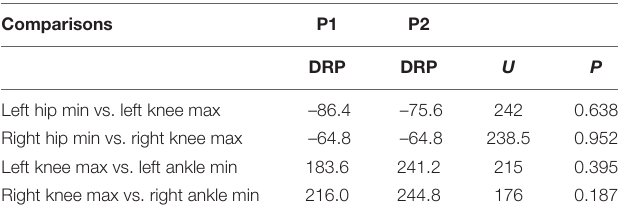
TABLE 3 | Discrete relative phase (DRP) values for left and right lower limb comparisons. Comparisons